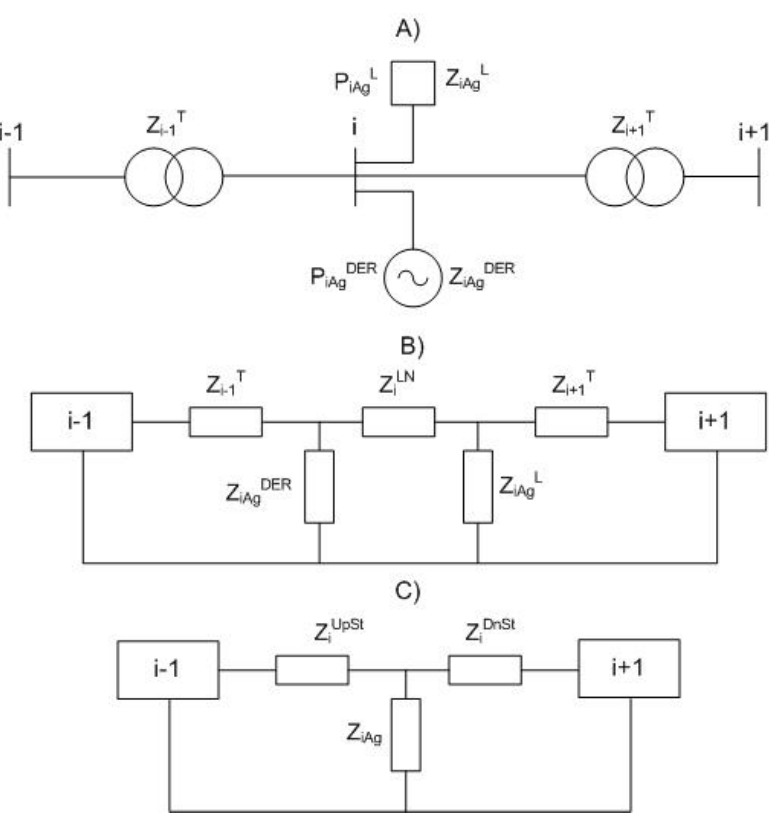
Figure 1. Aggregated impedance calculation. ( A ) Power system scheme between nodes i − 1 and i + 1; ( B ) Explicit impedances between nodes i − 1 and i + 1; ( C ) Aggregated impedances between nodes i − 1 and i + 1.